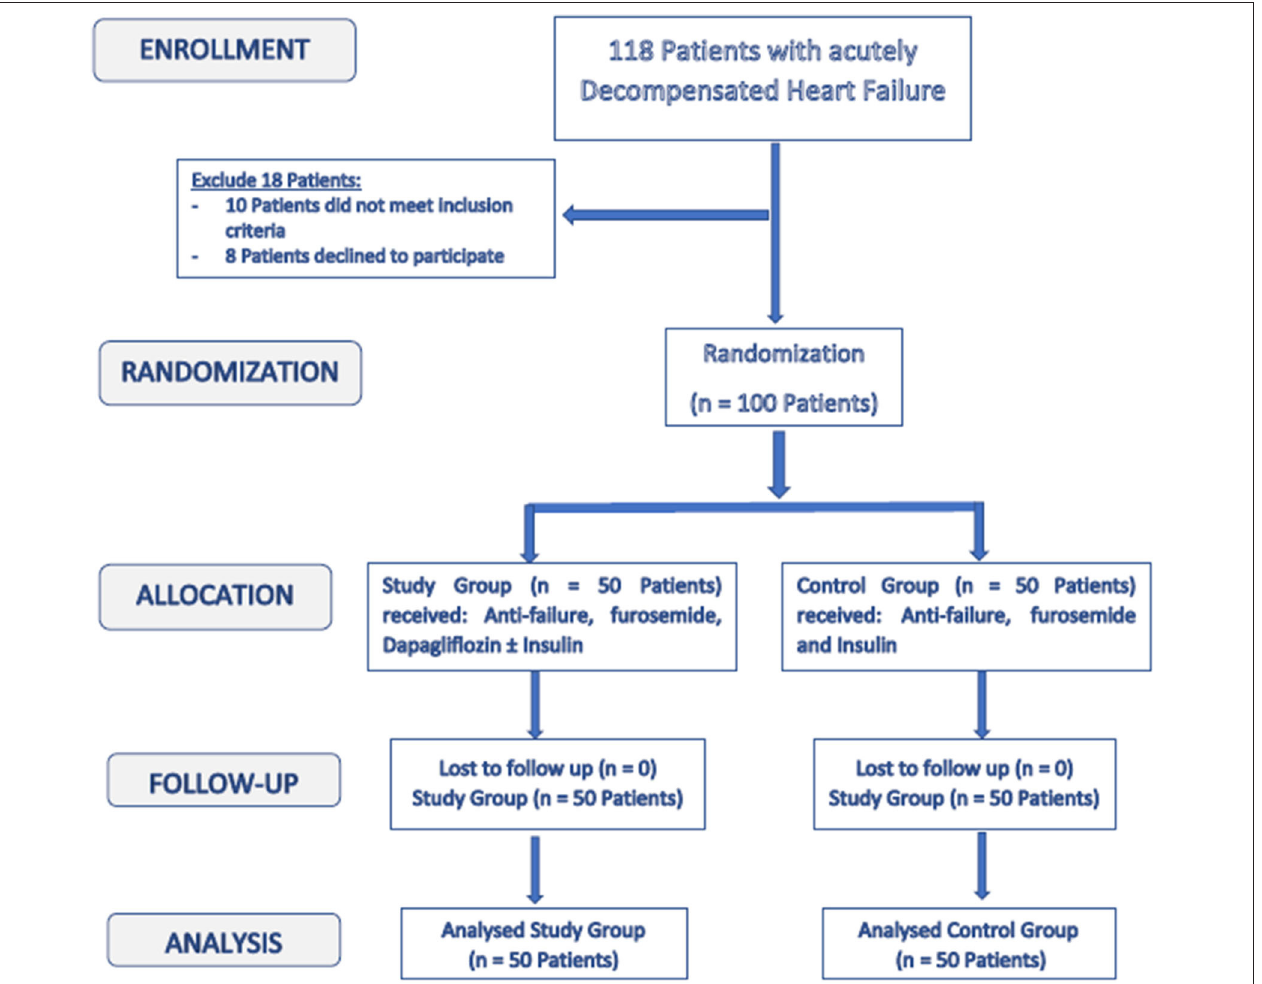
FIGURE 1 | Enrollment and follow up of the study